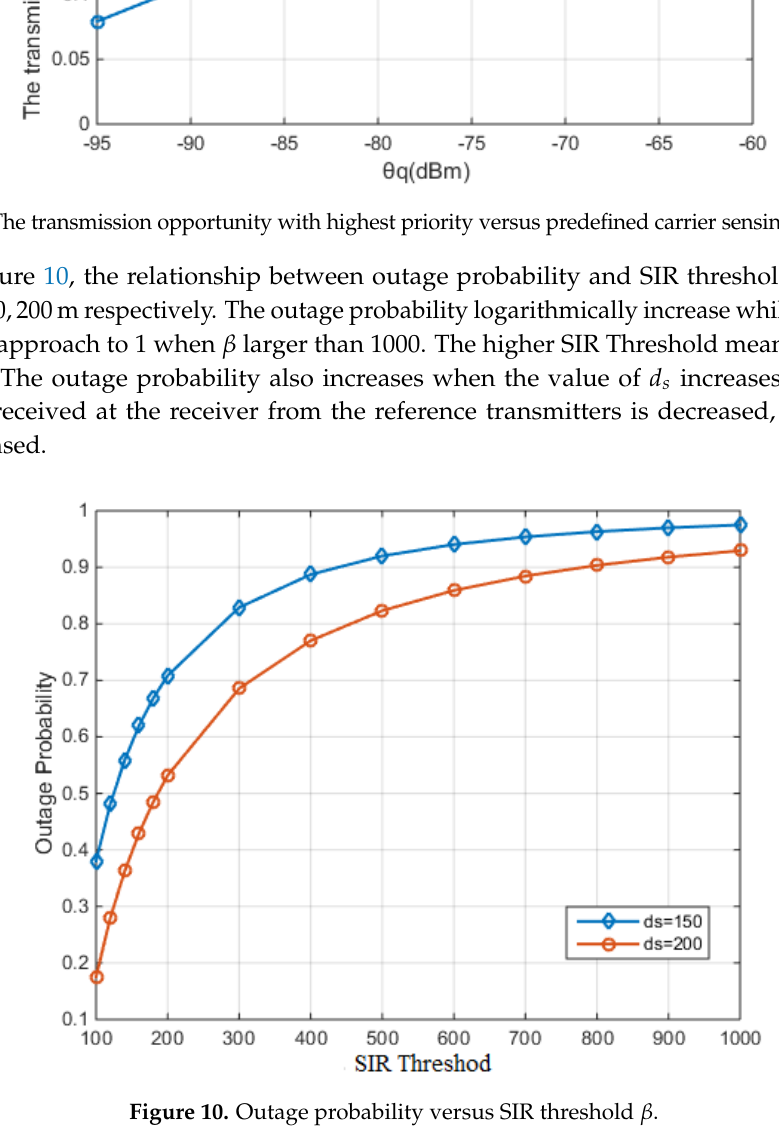
Figure 10. Outage probability versus SIR threshold β